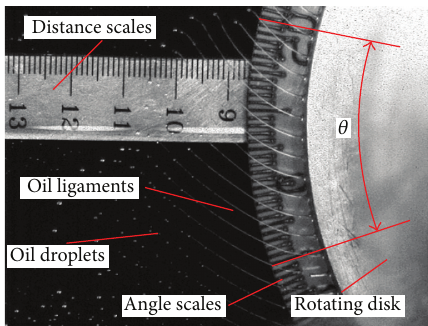
Figure 18: Measuring techniques of oil ligaments.